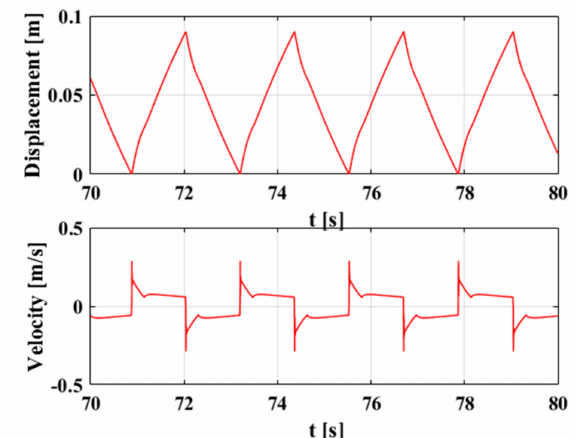
Figure 10. Curves of piston velocity and displacement.